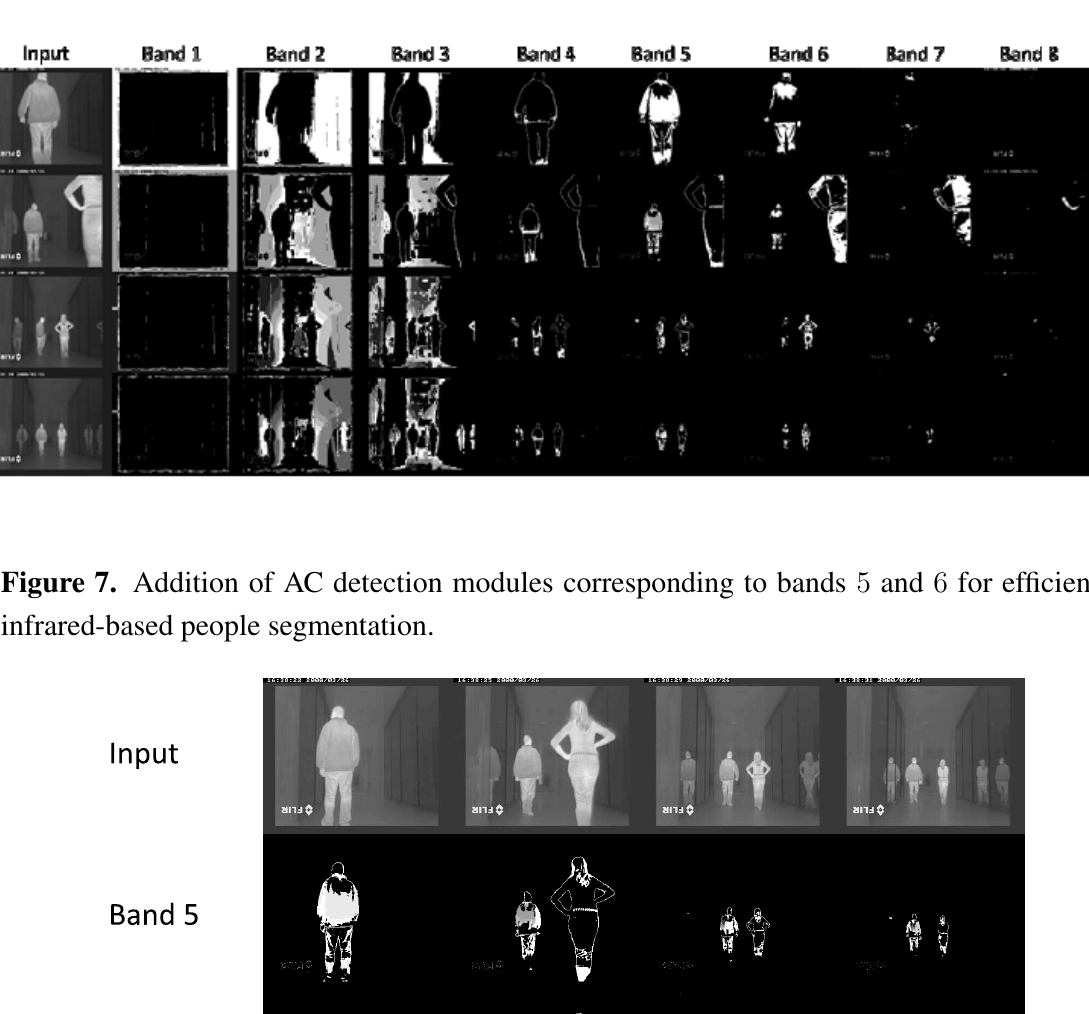
Figure 6. Result of AC detection modules for each gray level band.